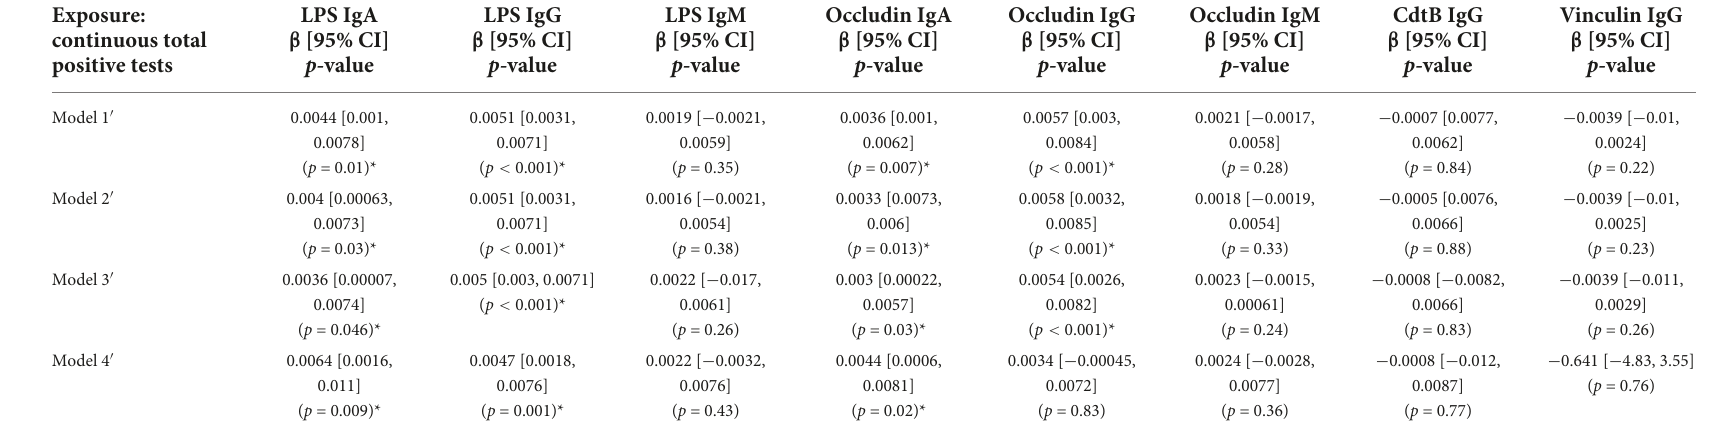
TABLE 4 Associations between intestinal permeability biomarkers and continuous summed food sensitivity measures ( n =